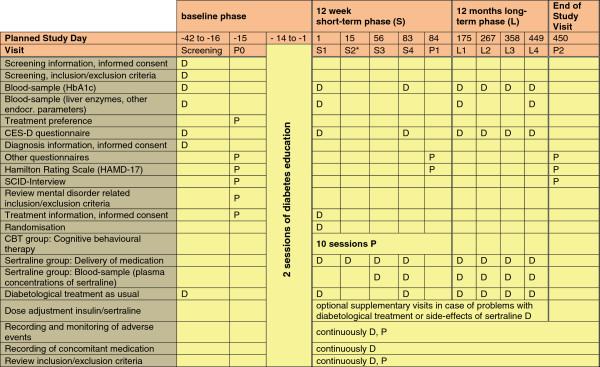
Measurements in the DAD study. Note: P = visit to the coordinating institutions were questionnaire and interviews will be administered by members of the research team (research assistants, psychologists); D = visit to the treating physician or research assistants in the diabetologic trial centres. *Visit S2 is optional by telefone or personally.